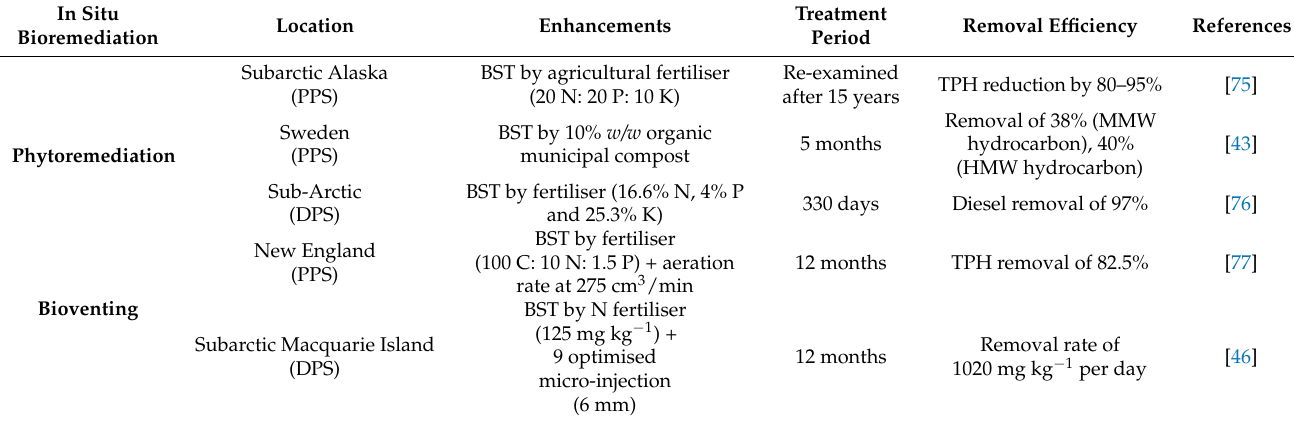
Table 4. Enhanced in situ bioremediation studies by biostimulation and/or bioaugmentation in cold climate regions. In Situ